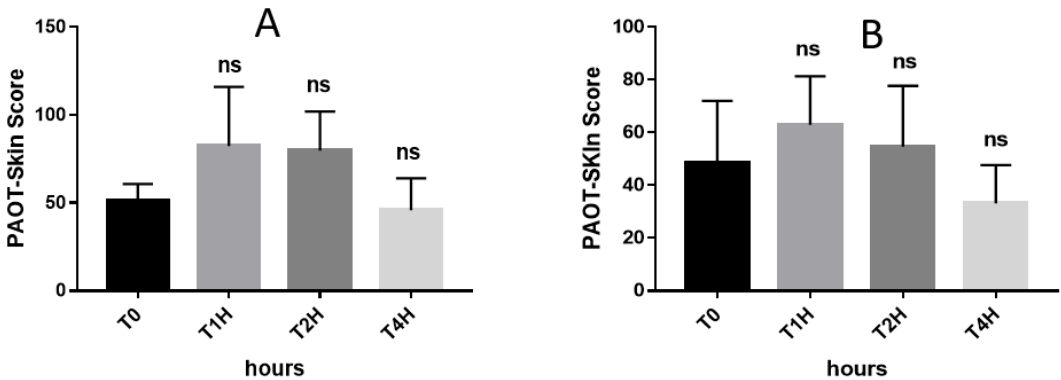
Figure 7. Effect of oral intake in natural vitamin C (Arkovital ® Pure’Energie containing Natural Vitamin C, n = 3, group VIb) ( A ) or synthetic (synthetic Vitamin C supplement, n = 3, group VIa) ( B )